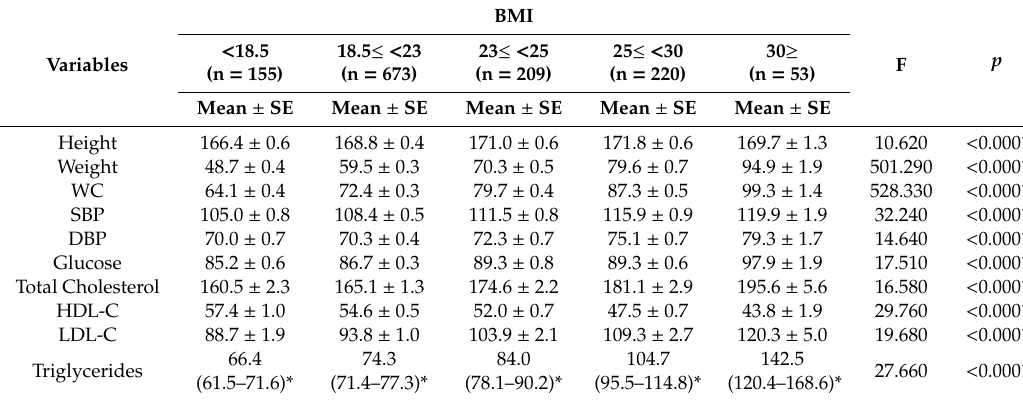
Table 3. Association between metabolic syndrome-related components and BMI classifications (n = 1310).